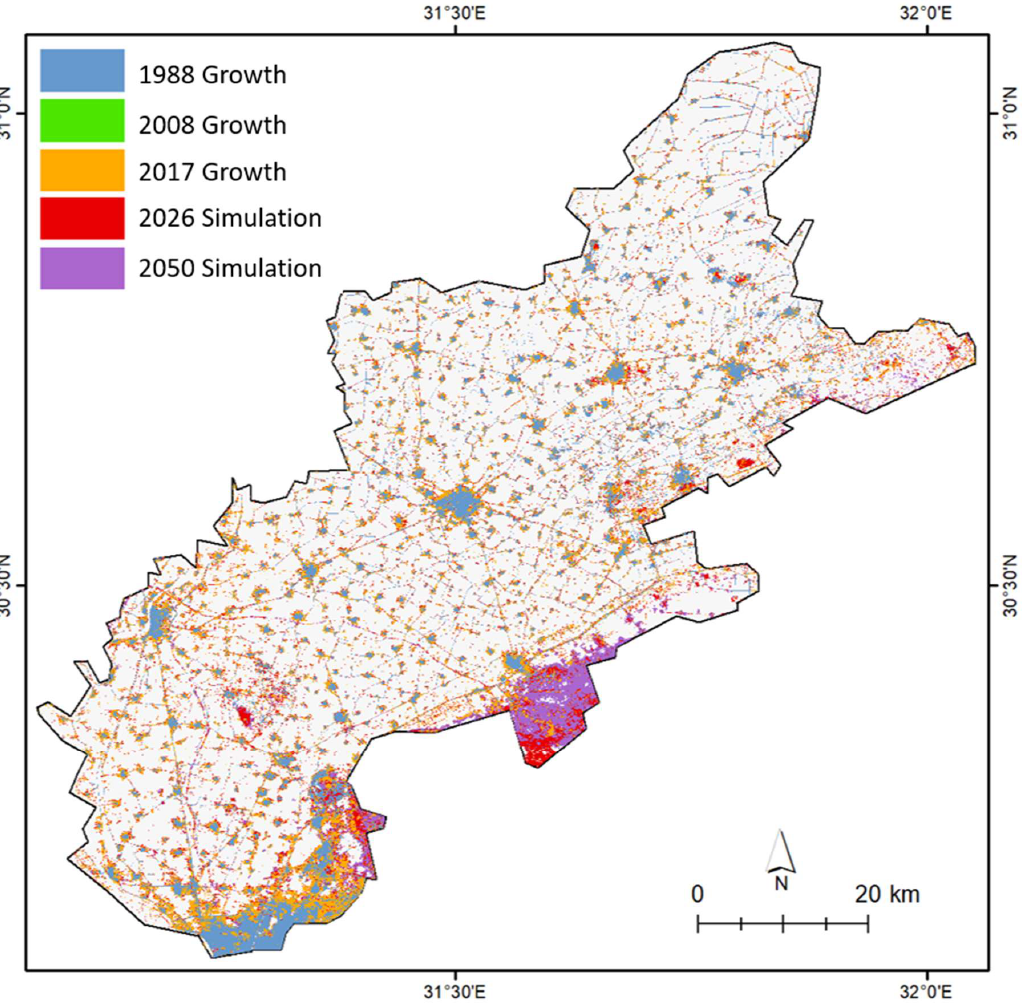
Figure 9. Actual urban growth and simulated urban growth are modeled including only the smaller cultivated lands flank within the ND. Most of the urban growth is mainly expanding from existing urban